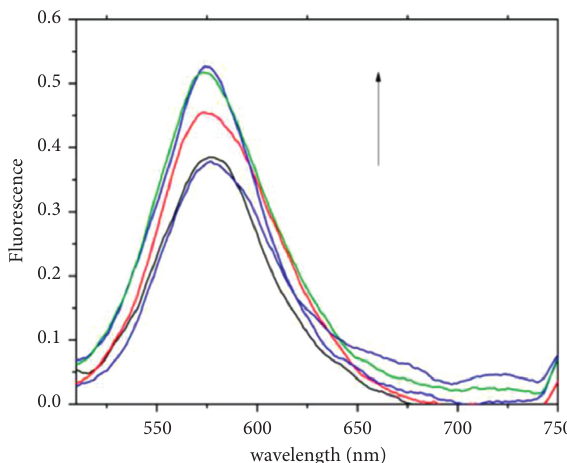
Figure 16: Emission spectra ( λ � 500nm) of coumarin 3 (1 × 10 − 5 M) in the presence of different concentrations of DNA in a 0.1M Tris- ex HCl buffer. The DNA concentrations used to obtain the different fluorescence intensities at 575nm are 0.400 (dark blue), 0.550 (black), 0.700 (red), 0.900 (green), and 1.100 μ g/mL (light blue).